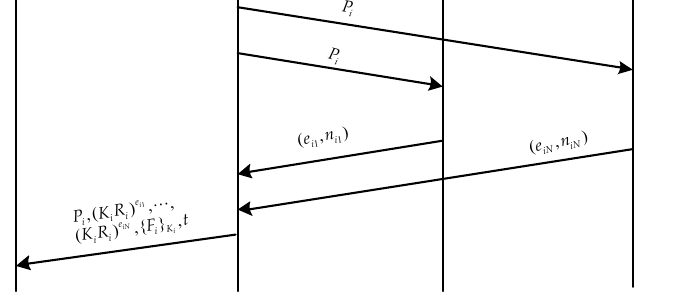
Figure 7. ADSS multi-KM file upload.